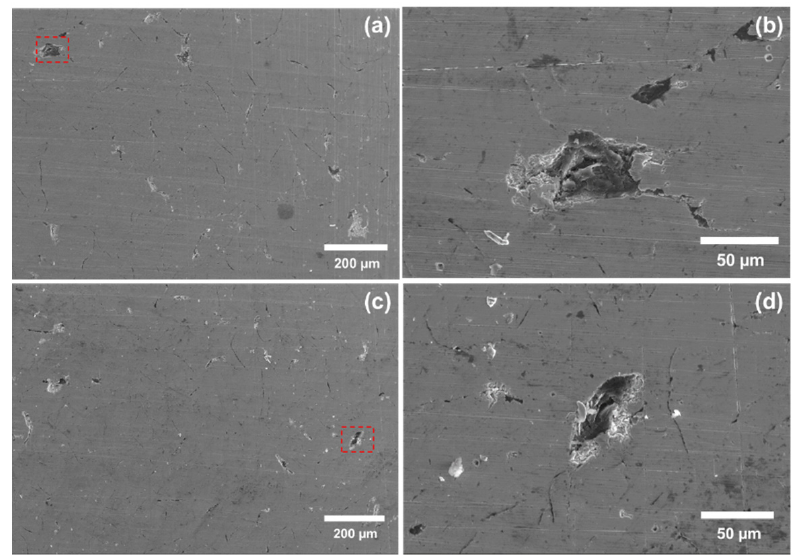
Figure 8. SEM micrographs of cast iron sample exposed to engine coolant containing 500 ppm chloride for 28 days are shown in ( a ) through ( d ). (Note: ( b ) and ( d ) illustrates high magnification SEM micrographs of highlighted regions in ( a ) and ( c ), respectively).